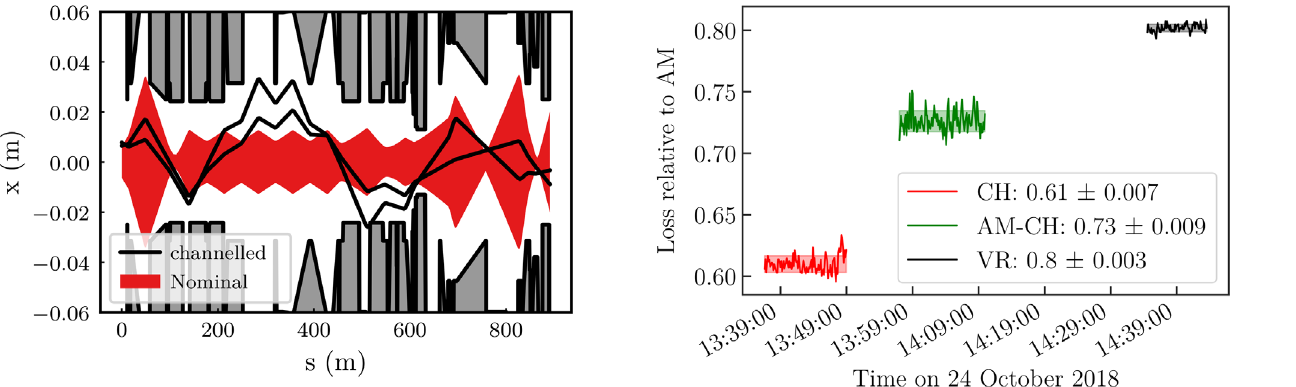
FIG. 19. Beam loss measured at the ES relative to amorphous (AM) during the stability checks. The crystal orientation was fixed in channeling (CH), in the channeling-amorphous (CH- AM) and volume reflection (VR) regimes. The loss reduction factor and RMS are indicated in the legend.